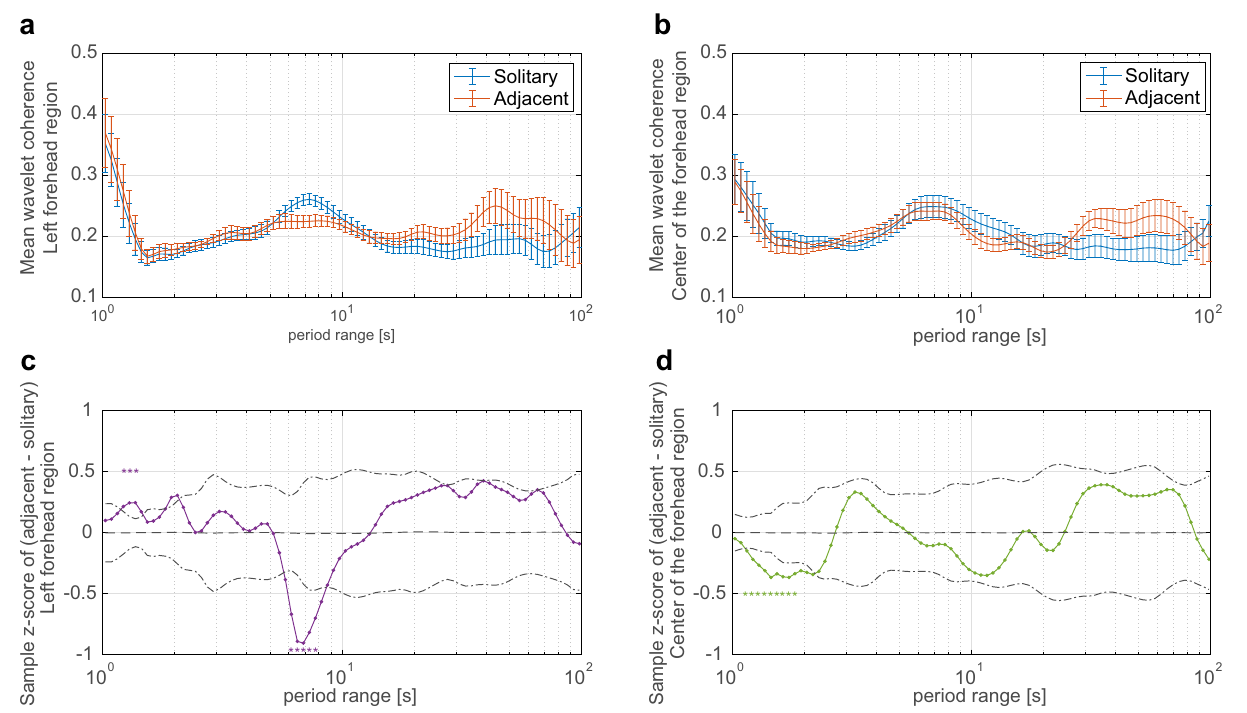
Figure 1. Comparison of interpersonal neural synchronization between adjacent and solitary conditions. Time-averaged wavelet transform coherence (WTC) of the neural signal under each condition for the ( a ) left and ( b ) center of the forehead. Each error bar indicates the standard error of the mean WTC for each pair. Sample z-score of between-condition difference (adjacent–solitary) for each period range for the ( c ) left and ( d ) center of the forehead. The asterisks indicate period ranges that showed statistically significant differences, and the dashed and long dashed dotted lines indicate the mean and ± 2 SD ranges of sample z-scores for the 10,000-permutation data. Left Period range [s]